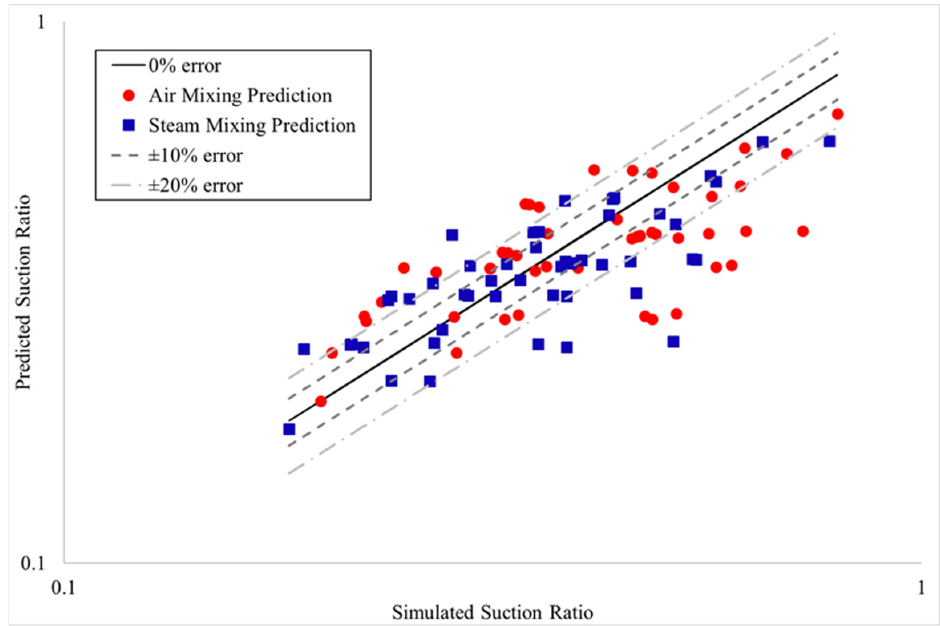
Figure 10. Suction ratio predicted by low suction ratio correlation vs. suction ratio from validated simulation.